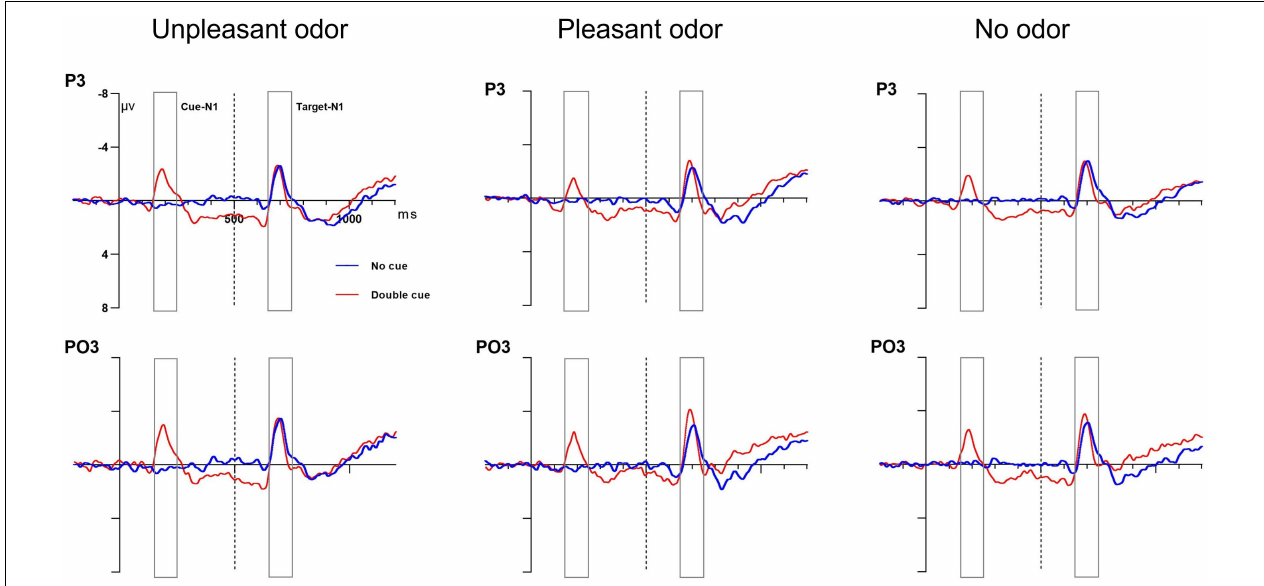
FIGURE 5 | Grand average ERP cue amplitude data for the alerting network. No cue (blue lines) and double cue (red lines) conditions at electrodes P3 and PO3. Cue onset at 0 ms (solid line) and target onset at 500 ms (dashed line).